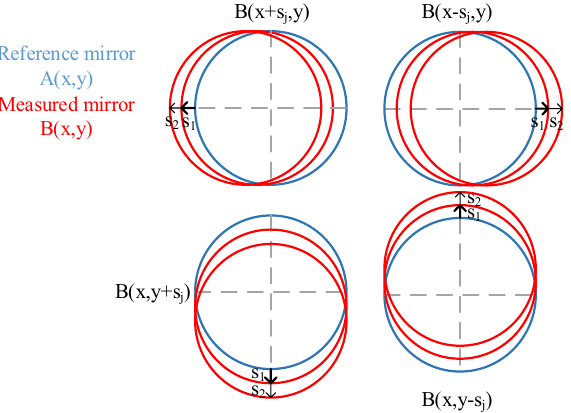
Figure 1. The proposed conjugate double shift differential absolute testing